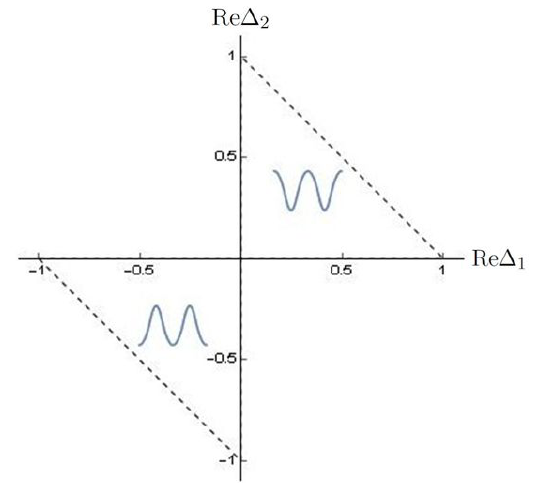
Figure 2 . The qualitative behavior of V Q ( x ; arg (cid:12); Re(cid:1) k ), as a function of x for (cid:12)xed Re(cid:1) 1 ; 2 and (cid:12)xed arg (cid:12) 2 ( (cid:0) (cid:25)= 2 ; 0), in the two complementary regions (cid:0) 1 < Re(cid:1) 1 ; Re(cid:1) 2 ; (cid:0) 1 (cid:0) Re(cid:1) 1 (cid:0) Re(cid:1) 2 < 0 (lower-left) and 0 < Re(cid:1) 1 ; Re(cid:1) 2 ; 1 (cid:0) Re(cid:1) 1 (cid:0) Re(cid:1) 2 < 1 (upper-right) of the space of the control- parameters Re(cid:1) 1 ; 2 . The M and W wings switch places if arg (cid:12) is taken to be inside (0 ; (cid:25)= 2) instead.